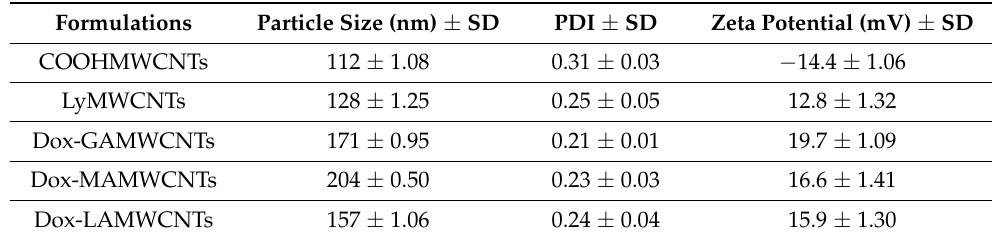
Table 3. Tabulated representation of the particle size, PDI and zeta potential of COOHMWCNTs, LyMWCNTs, Dox-GAMWCNTs, Dox-MAMWCNTs and Dox-LAMWCNTs (n = 3).